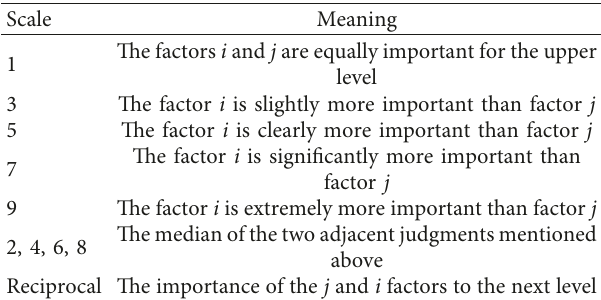
Table 2: Temperature and wildlife count in the three areas covered by the